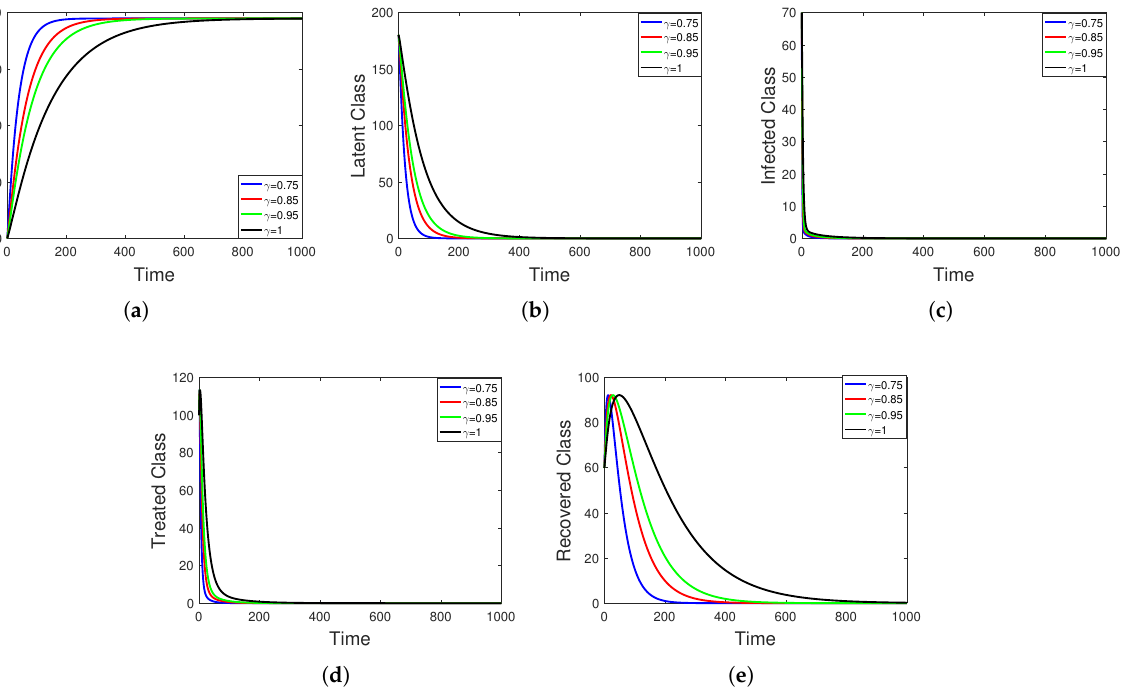
Figure 6. Simulations of the five classes ( a – e ) of the proposed model for different arbitrary orders γ = 0.75,0.85,0.95,1 for initial data and time duration for the TB model by taking the value of p = q =